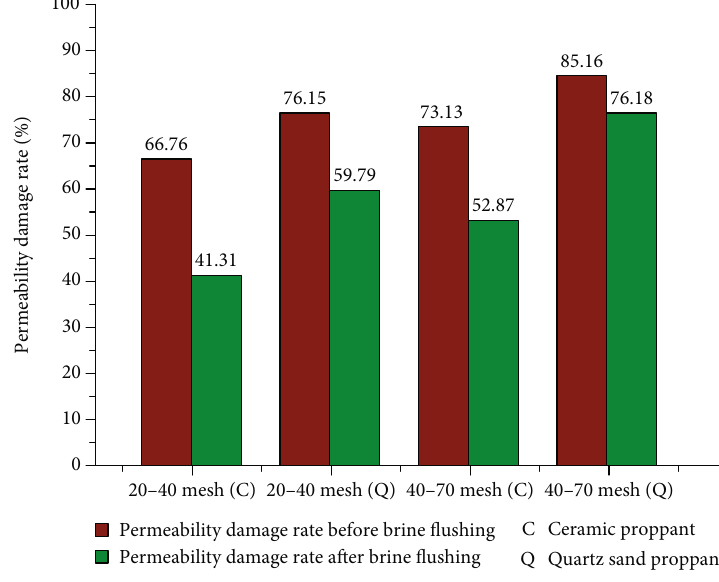
Figure 4: In fl uence of di ff erent proppant types on coal sample permeability damage